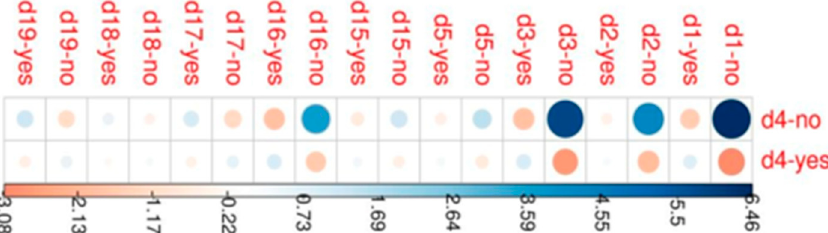
Figure 1. Correlation plot depicting Pearson residual related to response to question 4. Univariate logistic regression was performed to identify which of the parameters, evaluated by the questionnaire, are able to influence appropriate communication on Human Papillomavirus risks.